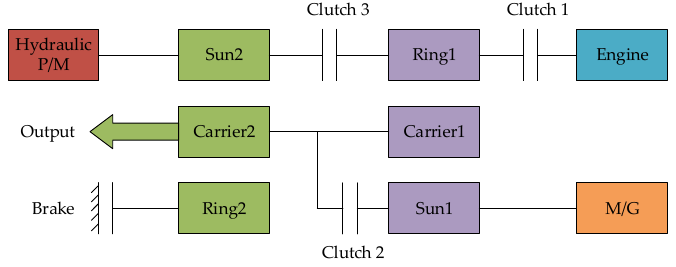
Figure 1. Structural diagram of the hydraulic/electric synergy powertrain.